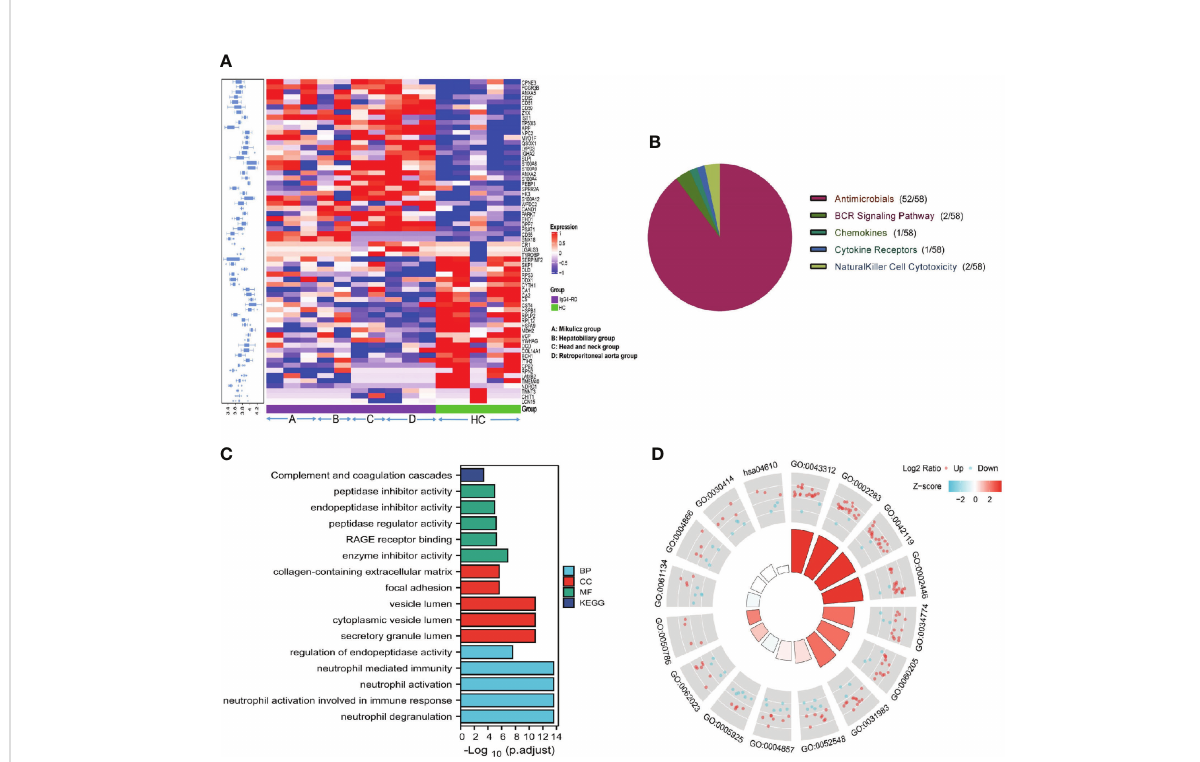
FIGURE 1 Summary of the DEPs in IgG4-RD and HC group in saliva. (A) The expression heatmap of DEPs in IgG4-RD and HC group in saliva. The blue to red in the right indicates the expression level from low to high. Proteins have carried out hierarchical clustering by calculating average distances. (B) Immune categories of DEPs identi fi ed in saliva between IgG4-RD patients and HC samples. Different color represents various immune related categories from IMMPORT database. (C) Enriched GO terms of differentially expressed proteins in saliva between IgG4-RD patients and HC groups. (D) Each column in the inner ring corresponds to a GO category, and the height of each column represents the p.adjust value (higher the column, smaller the p.adjust value). The color of each GO category represents the Z-score value, and “ up ” and “ down ” label represents the molecule category based on Log2 Ratio calculation, respectively.